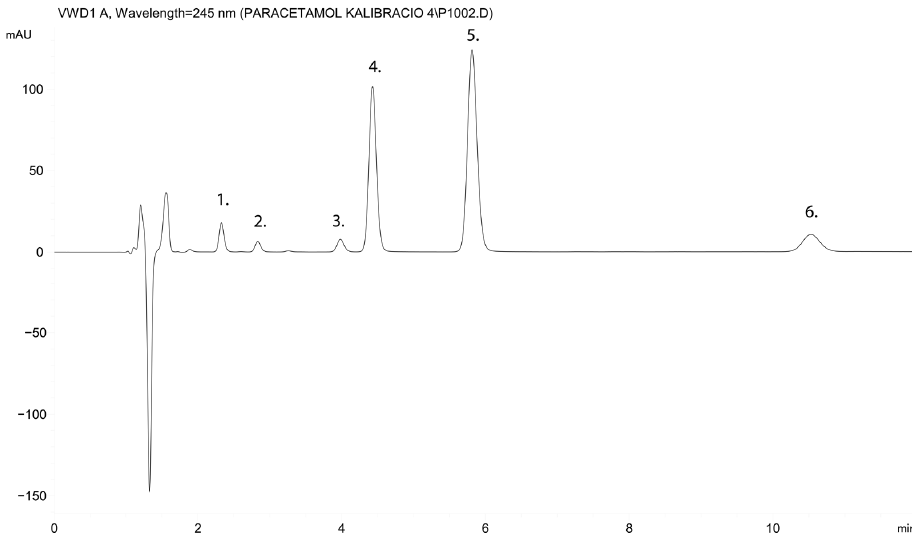
Figure 1. HPLC chromatogram of the standards prepared with the blank perfusate. Peak 1 is paracetamol β‐ D ‐ glucuronide (t R = 2.305 min), peak 2 is paracetamol cysteine (t R = 2.776 min), peak 3 is paracetamol sulphate (t R = 3.904 min), peak 4 is paracetamol (t R = 4.354 min), peak 5 is theophylline (internal standard) (t R = 5.701 min), and peak 6 is paracetamol mercapturate (t R = 10.271 min).